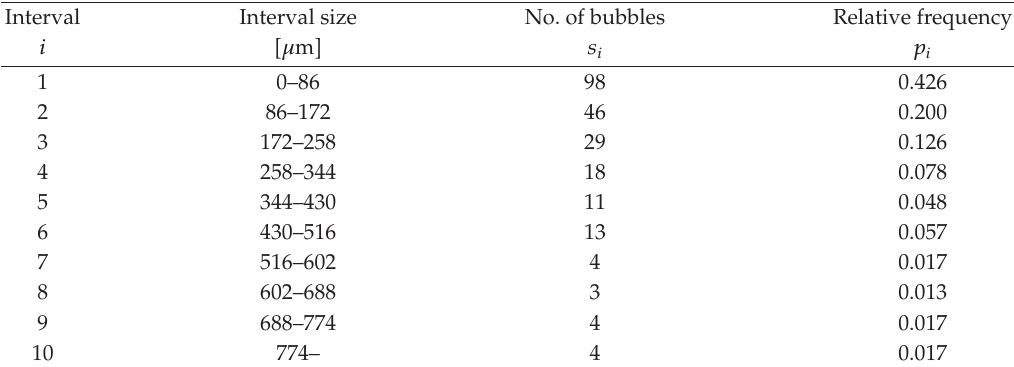
Figure 2: The monotonously decreasing number of bubbles of the foam pictures. Table 1: The number of intervals i and their interval sizes to obtain bubble-size distributions. As an example, the data of the bubble image in Figure 1 are given: the absolute number of bubbles s i and the relative frequencies p i . Note that the last interval is